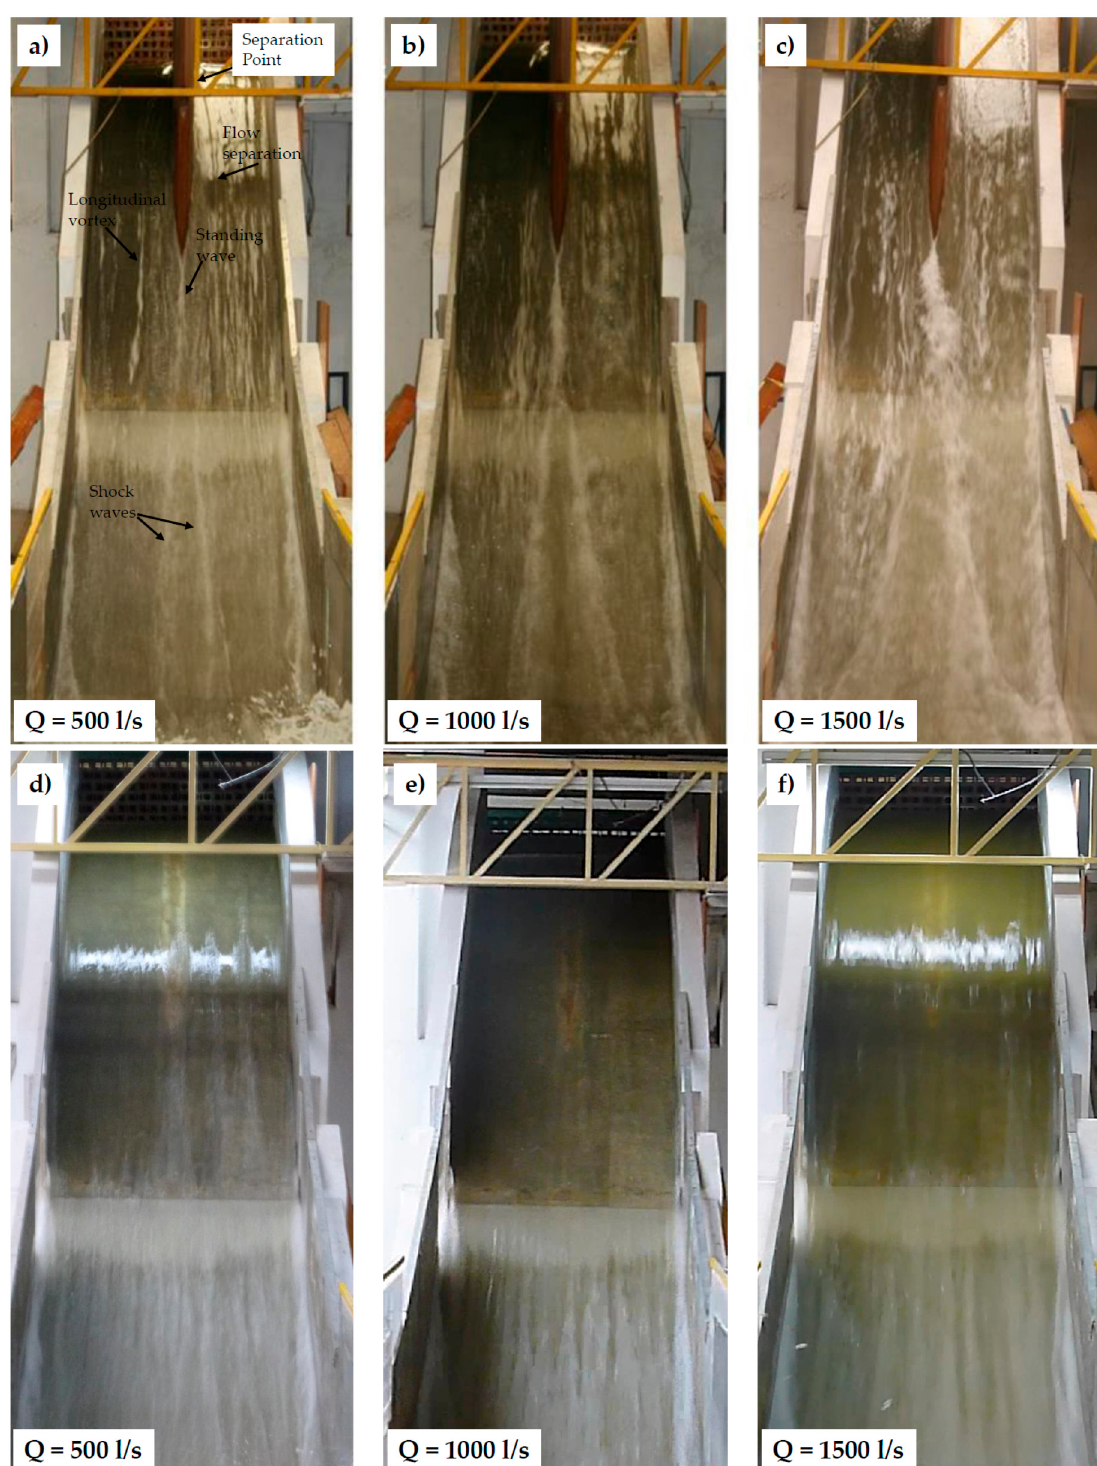
Figure 6. Flow patterns for both configurations with the three tested water discharges: ( a ) 500 L/s with pier, ( b ) 1000 L/s with pier, ( c ) 1500 L/s with pier, ( d ) 500 L/s without pier, ( e ) 1000 L/s without pier, ( f ) 1500 L/s without pier.